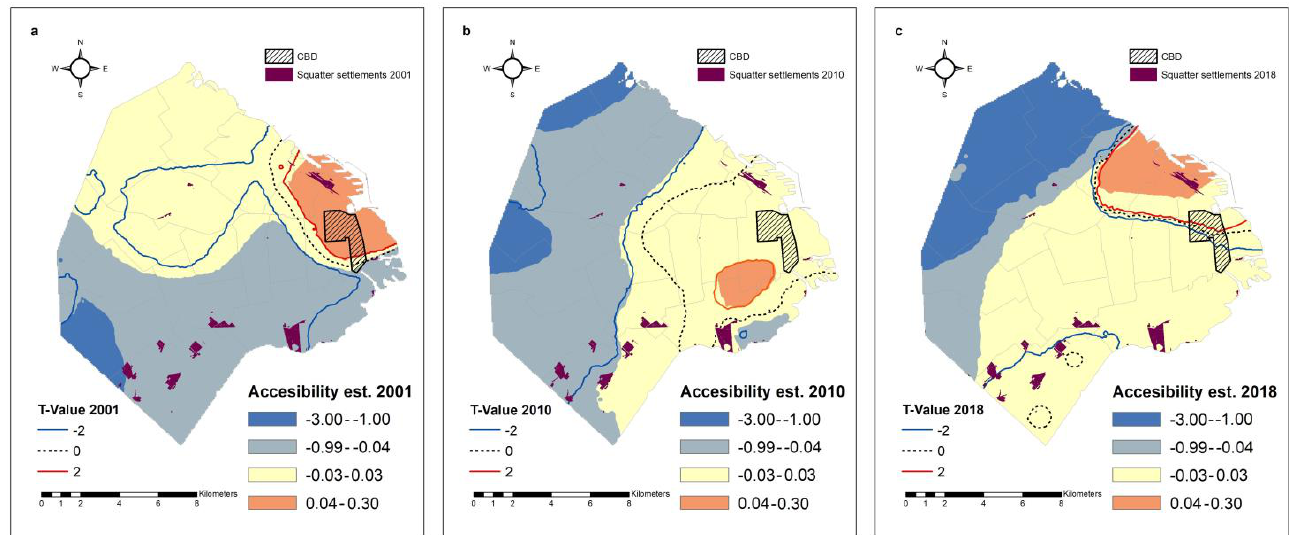
Figure 5. GWR result, coefficient estimates of accessibility to squatter settlements and t -values of ( a ) 2001, ( b ) 2010, and ( c ) 2018.